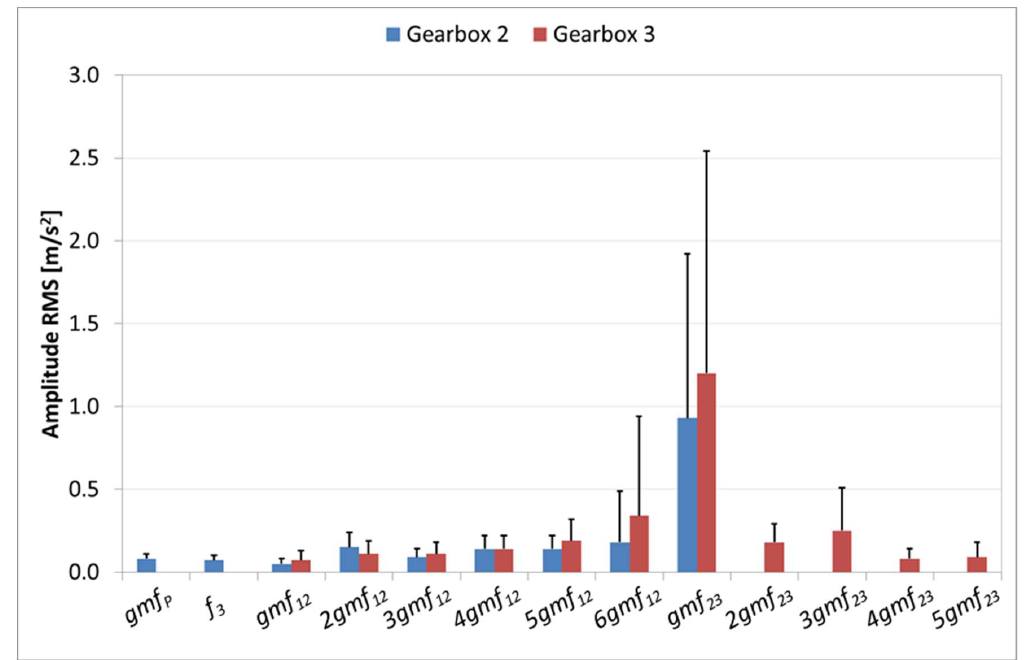
Figure 10. Mean vibration acceleration root mean square (RMS) and standard deviation values for the main frequencies on the high speed side of the drive train.